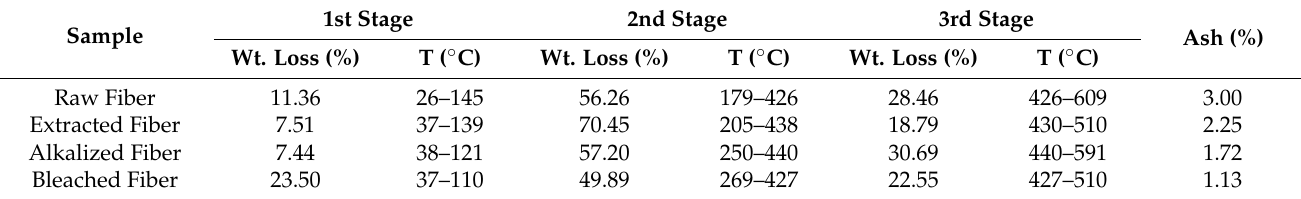
Table 7. Thermogravimetric analysis of fibers at different extraction steps.